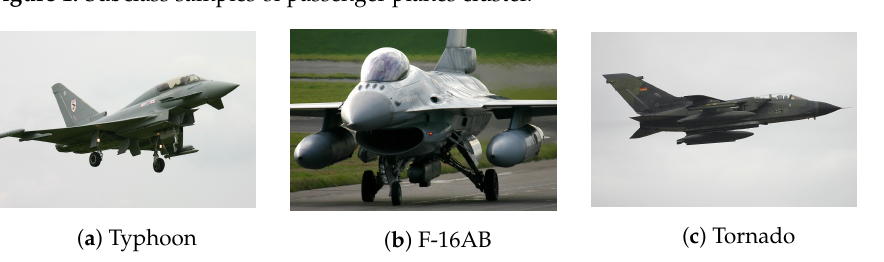
Figure 1. Subclass samples of passenger planes cluster.